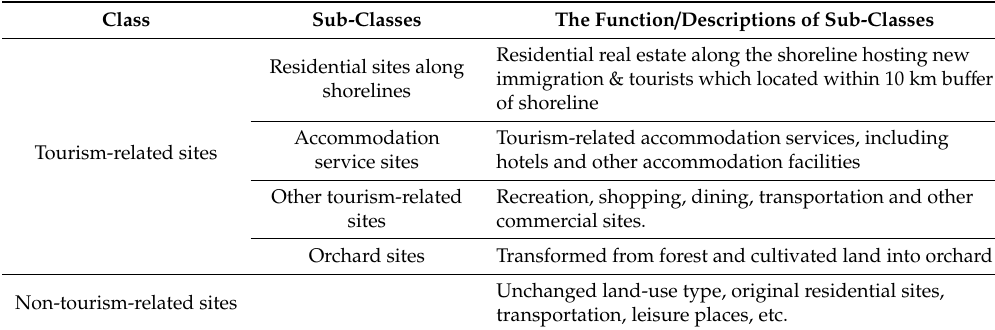
Table 2. The function-defined classification of